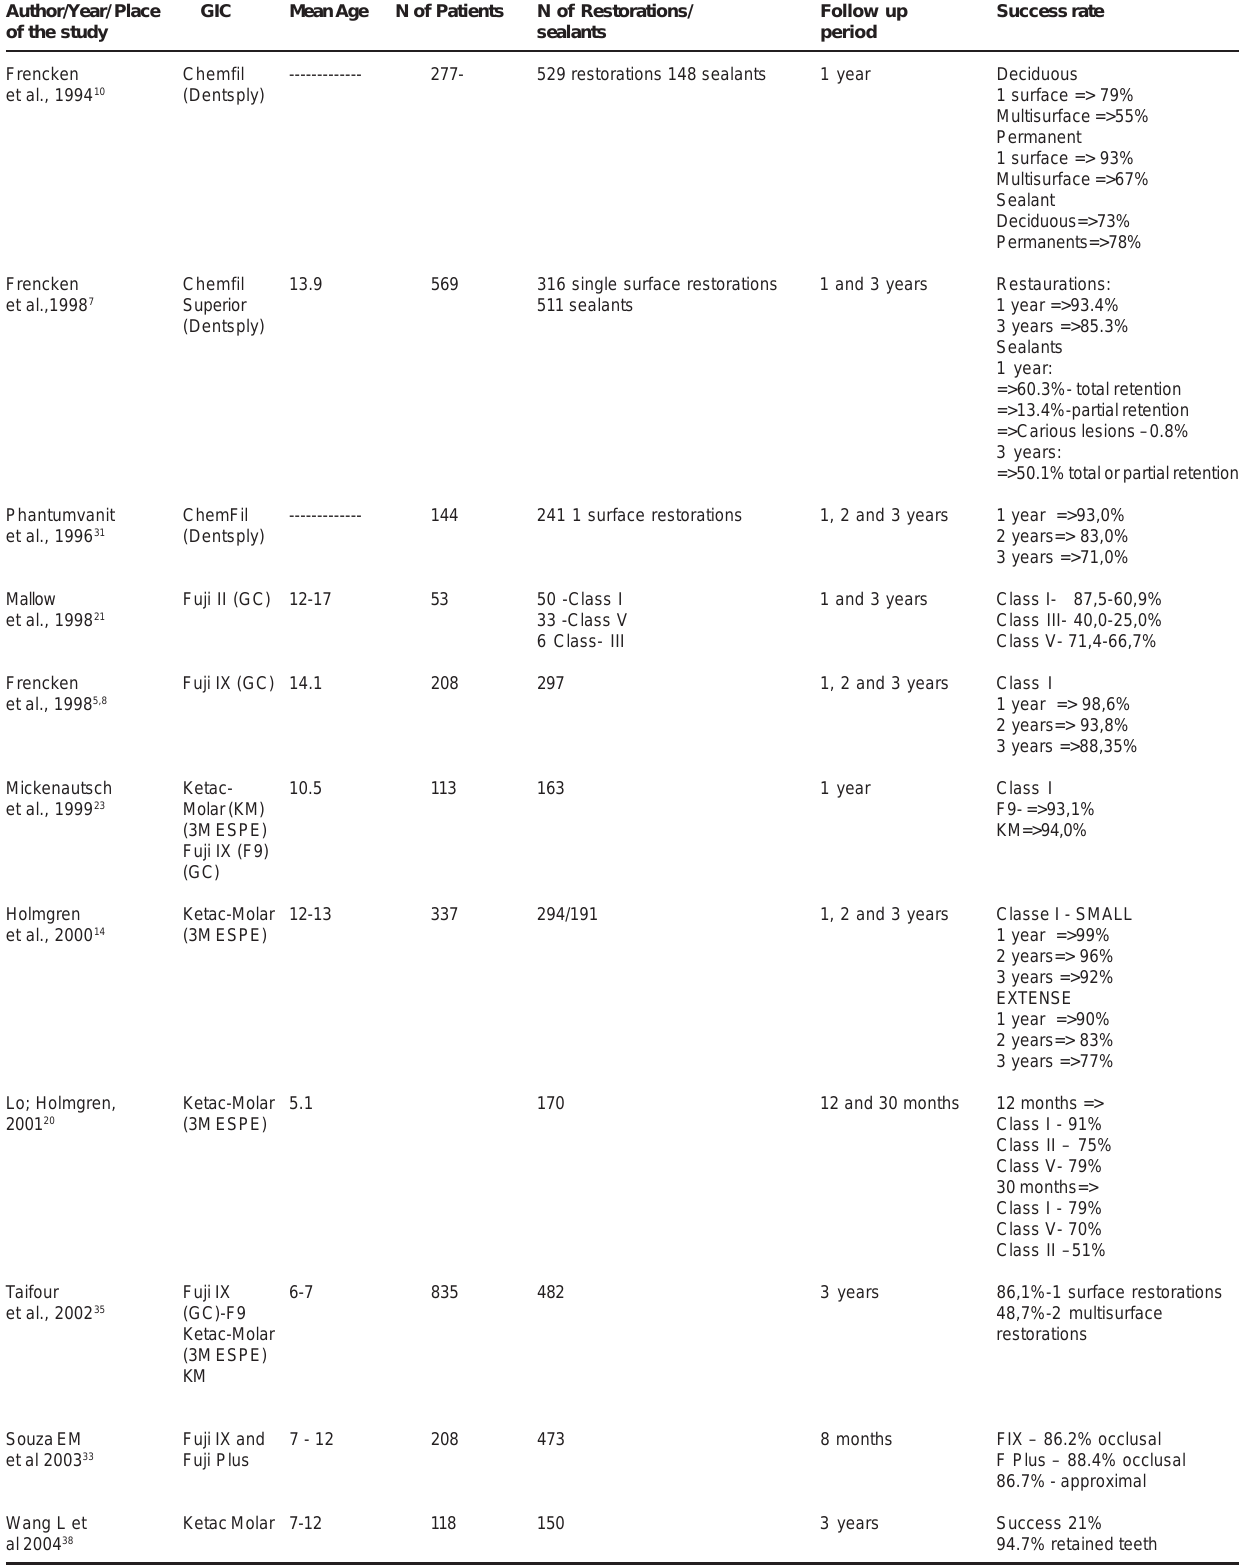
TABLE 1- Some of the studies found using the PUBMED search